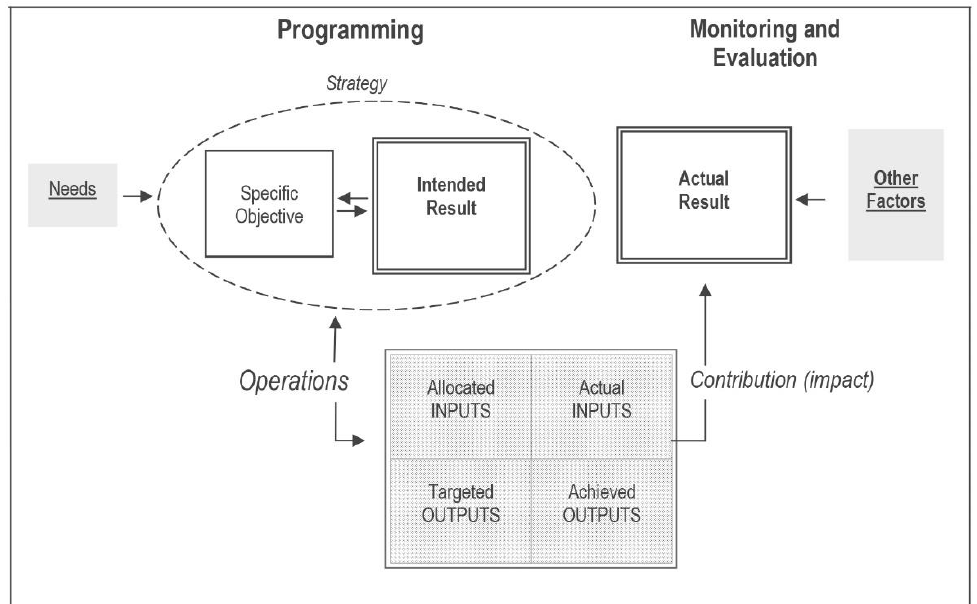
Fig. 1. Impact in relation to programming, monitoring and